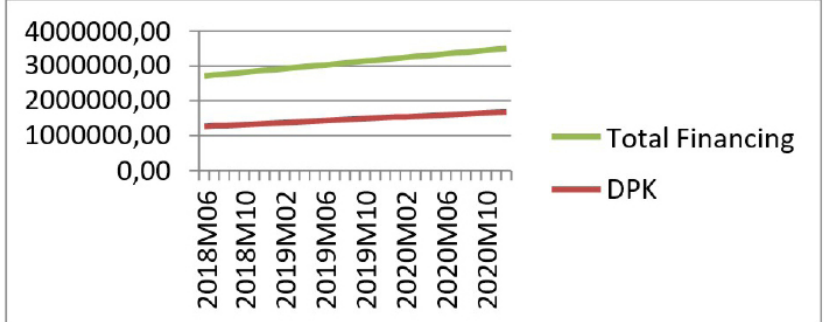
Figure 5: The Forecasting of Financial Inclusion in East Java through BPRS using Usage Indi - Source: Data Processed